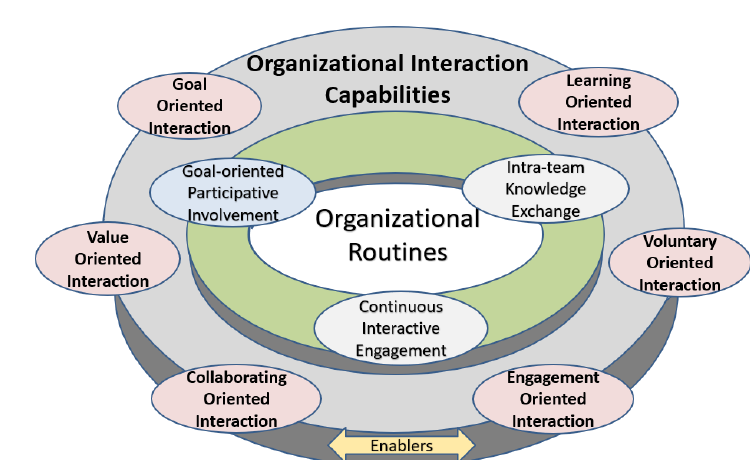
Fig. 1. Derivation of Empowering Knowledge-Based Interaction Concept